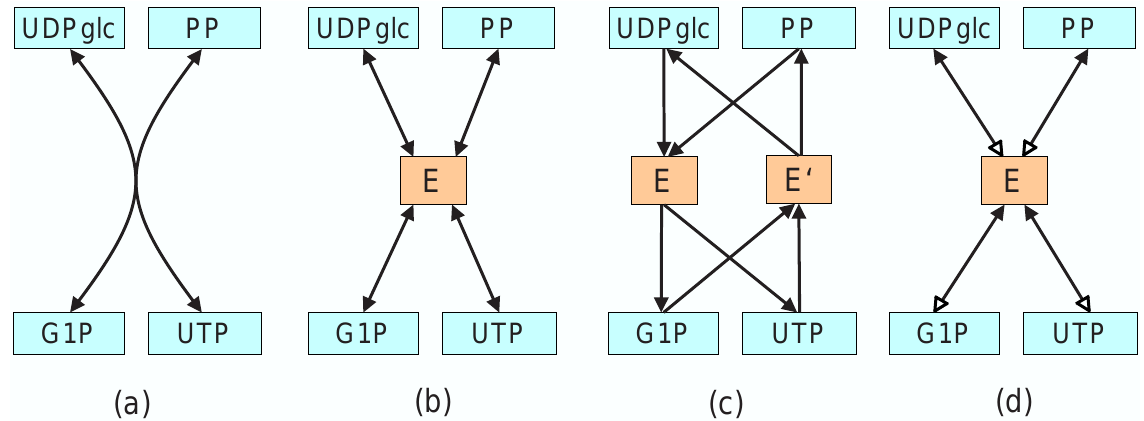
Figure 3: Different representations of an enzymatic reaction by the example of the UDPglucose pyrophosphorylase (E), which is catalysing the reversible reaction UDPglc + PP <=> G1P + UTP . The Different representations are: a) directed hypergraph (with reversible reaction), b) di- rected bipartite graph (with reversible reaction), c) one vertex for each direction of the reaction, and d) method used within SyBME. Abbreviations: see Fig.